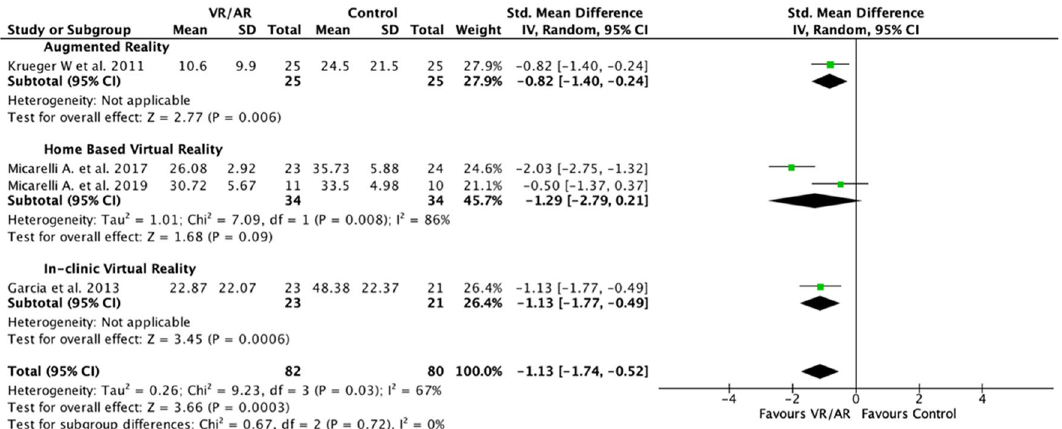
Figure 4. Post-intervention symptom index score (DHI) intervention type subgroup analysis. SMDs between VR/AR and control vestibular rehabilitation for AR, home based VR and in-clinic VR are listed. DHI dizziness handicap index, SMD standardized mean differences, VR virtual reality, AR augmented reality.